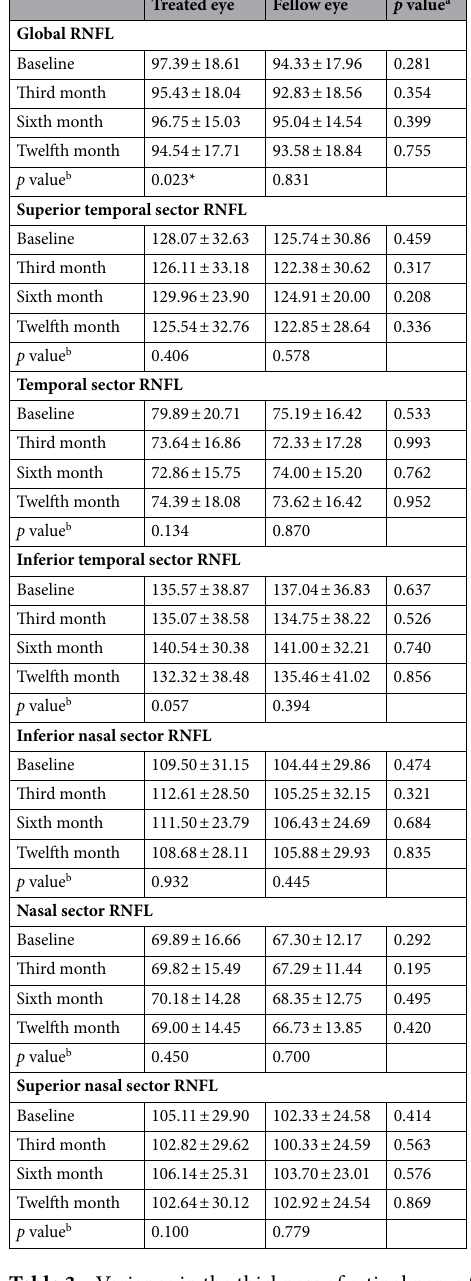
Table 3. Variance in the thickness of retinal nerve fiber layer (μm) in the group administered intravitreal aflibercept injection. RNFL retinal nerve fiber layer. a Comparison between the treated eyes and fellow eyes in each period (Mann–Whitney U -test). b Comparison between the baseline and twelfth month for each value (Wilcoxon signed-rank test). * p